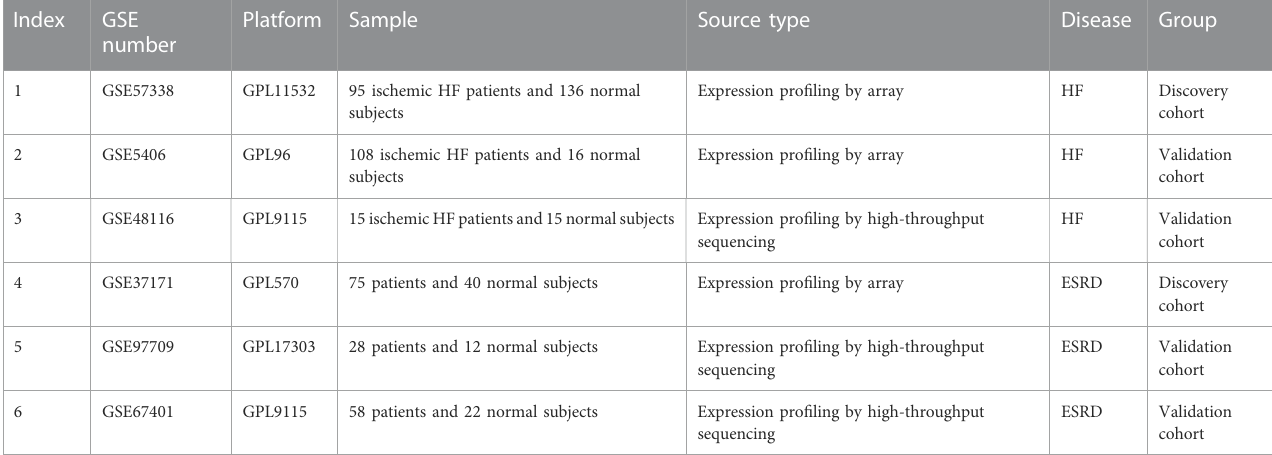
TABLE 1 Summary of the four GEO datasets involving HF and ESRD